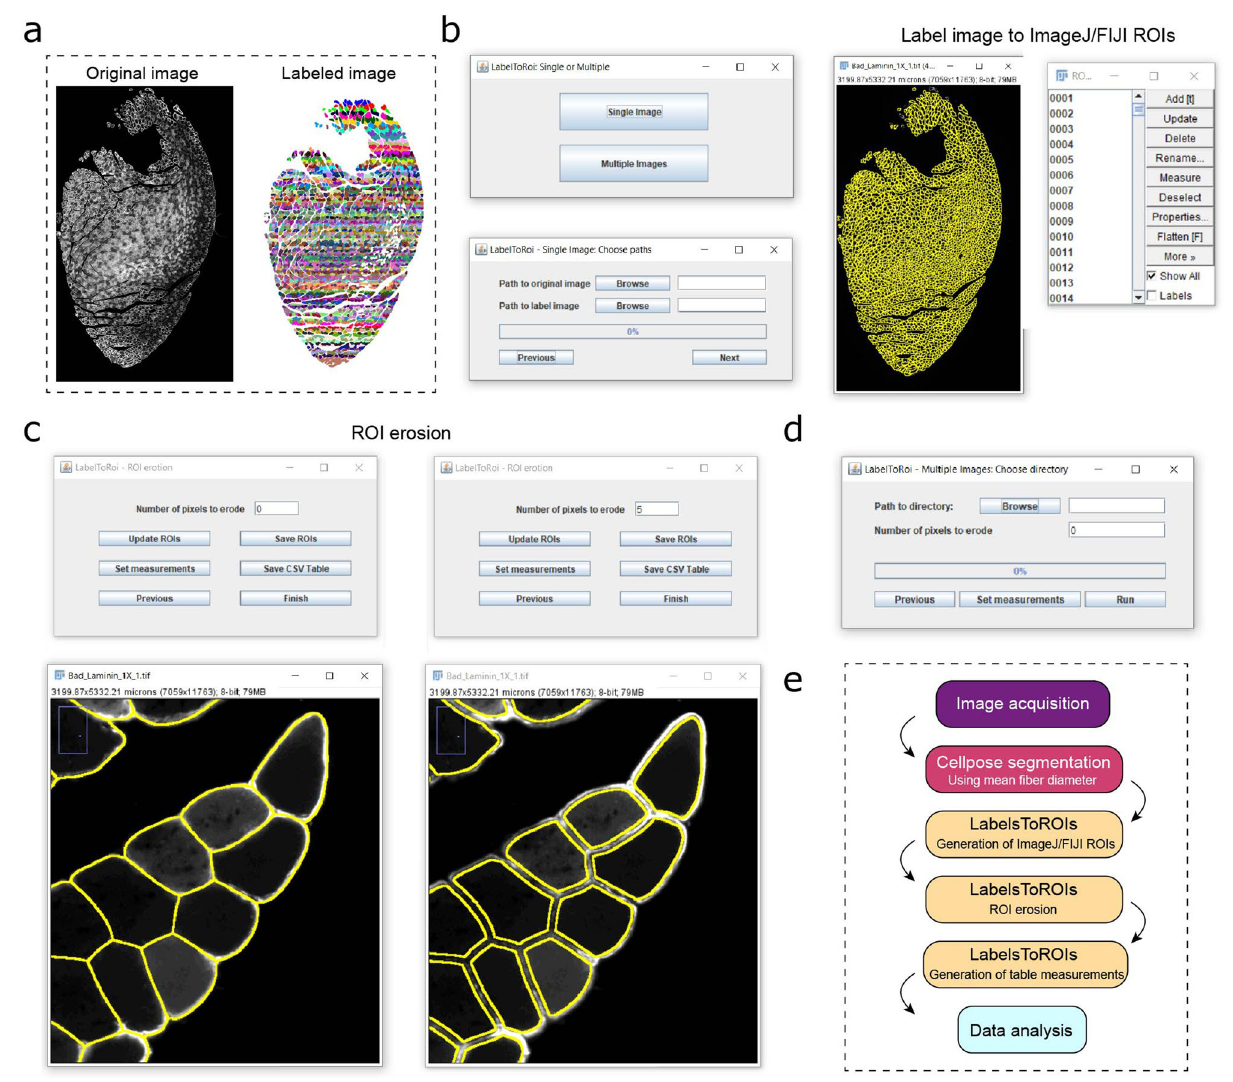
Figure 7. Development of LabelsToROIs plugin to analyze label images in FIJI/ImageJ. As indicated in ( a ), the plugin takes as input an original image and a labeled image generated using Cellpose or another software. ( b ) The plugin allows to automatically extract the segmentations in the label images and generate the corresponding FIJI/ImageJ regions of interest (ROIs). ( c ) Once generated, the ROIs can be eroded by a fixed number of pixels until the segmentations correctly delineate the objects of interest. The ROI files can be saved, and different measurements can be selected to generate table measurements. ( d ) The LabelsToROIs plugin also allows for simultaneous processing of multiple images, enabling the generation of ROIs, ROI erosion and table measurements in one step, while automatically saving all the files for future inspection. ( e ) A diagram of the proposed pipeline for the automatic analysis of skeletal muscle